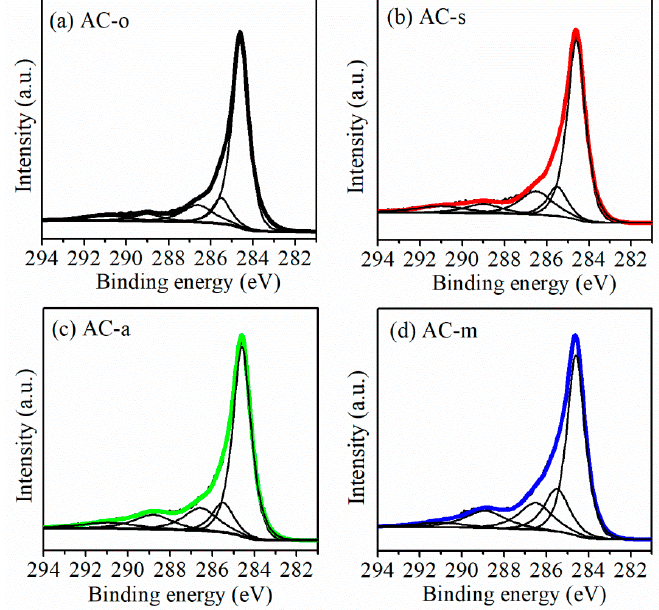
Figure 3. C1s XPS spectra of the samples. ( a ) AC-o, ( b ) AC-s, ( c ) AC-a, and ( d ) AC-m.. Table 2. Carbon and oxygen contents in the studied samples obtained from XPS. Table 2. Carbon and oxygen contents in the studied samples obtained from XPS. Samples